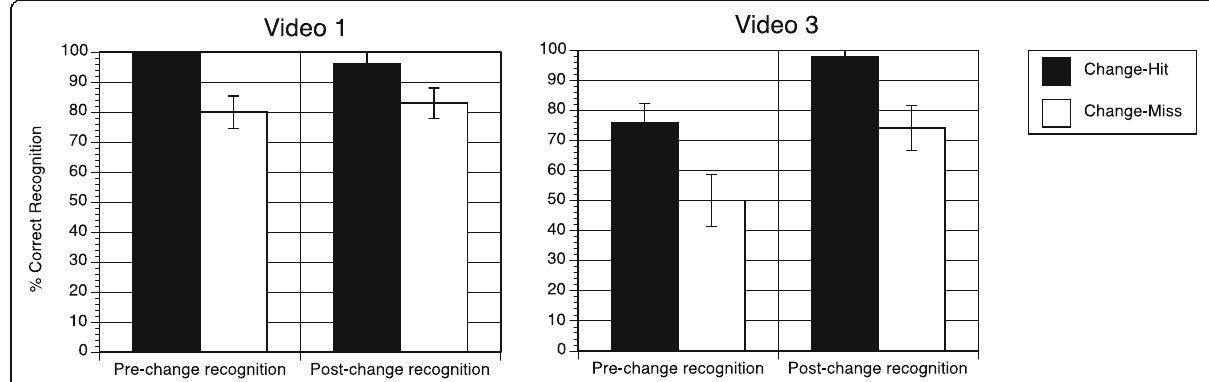
Fig. 2 Percent accuracy on visual recognition for change-hit and change-miss trials in experiment 2. Error bars represent standard